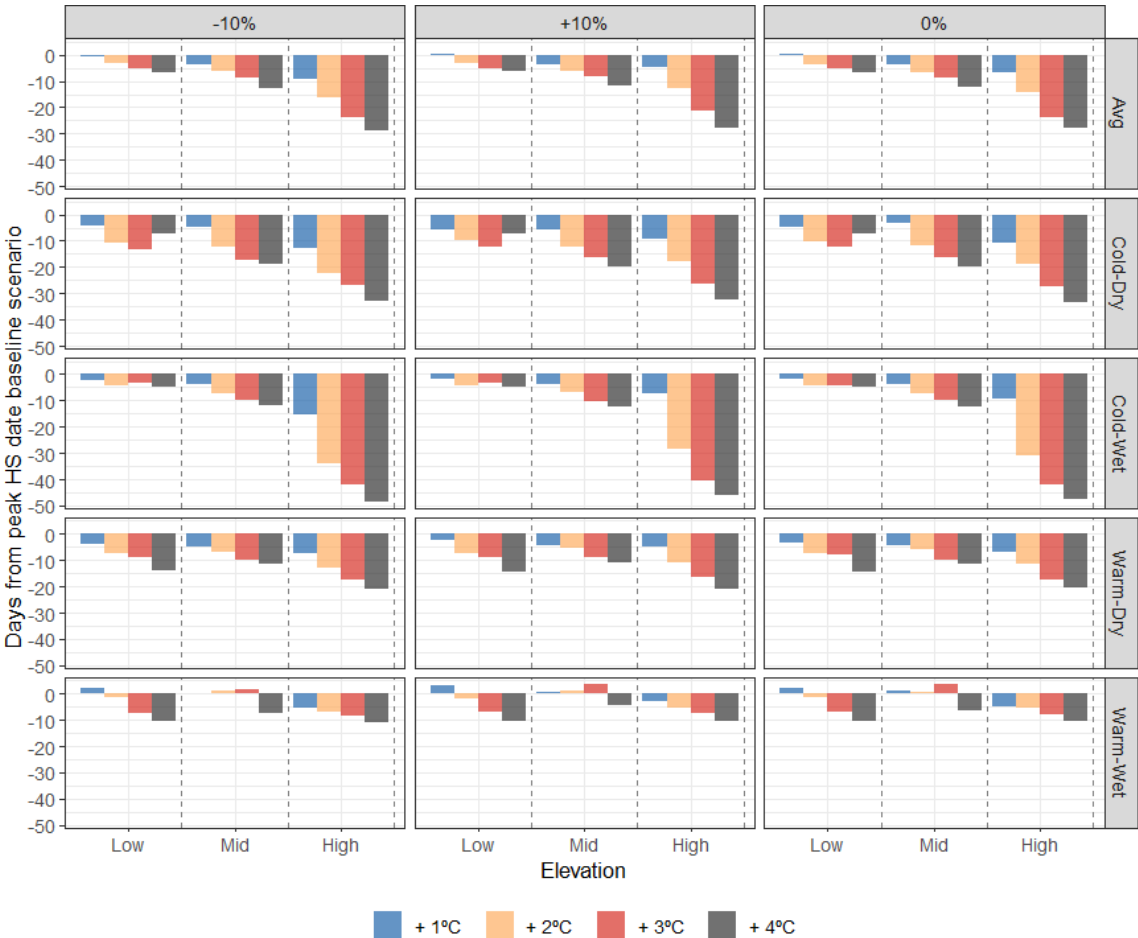
Figure 6. Difference (days) from the baseline peak HS date at three different elevations and during the four different temperature (colors) and precipitation shifts (columns) for each season (boxes). Table 3. Snow duration, snow ablation, and peak HS date sensitivity to temperature and precipitation change during the four different compound season